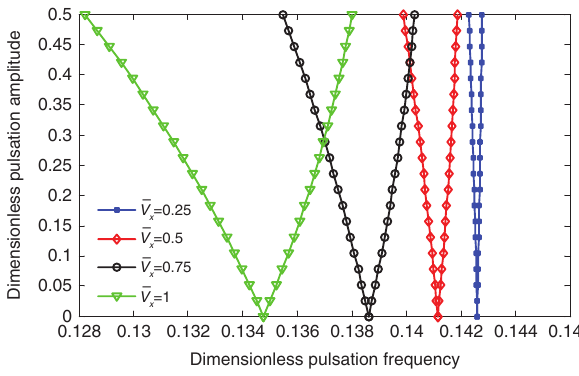
Figure 7: Effect of the fluid velocity on the dimensionless pulsation amplitude versus dimensionless pulsation frequency.